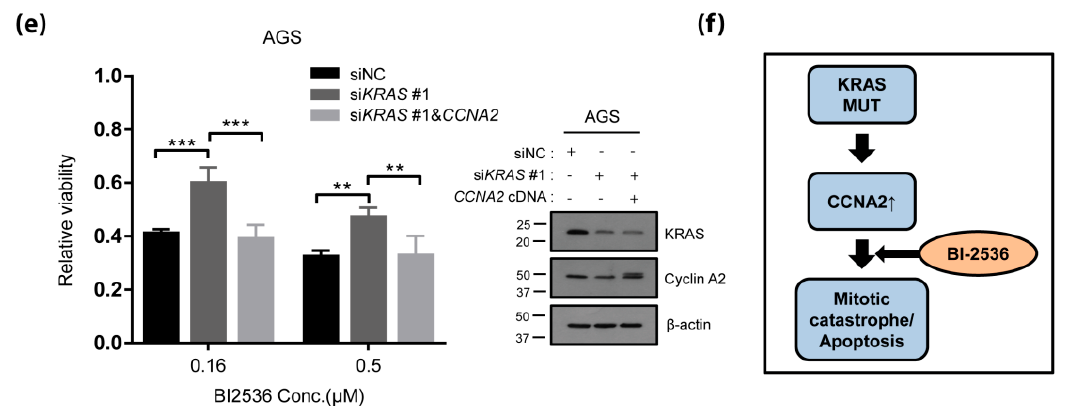
Figure 4. Oncogenic KRAS driven CCNA2 upregulation confers sensitivity of KRAS mutant cancer to PLK1 inhibitors.( a ) Comparison of CCNA2 expression levels between wild-type (WT) and pan- RAS ( KRAS , HRAS and NRAS ) or mutant KRAS tumor samples (pan-cancer and gastric cancer) in the Cancer Genome Atlas (TCGA) cohort; ( b ) cumulative distribution fraction plots of drug response (median-centered AUC) in the 37 gastric cancer cell lines show that KRAS mutant cell lines had higher sensitivity to BI-2536 and volasertib. p values were calculated by two-sided Kolmogorov–Smirnov tests (KS-test); ( c ) evaluation of cyclin A2 and KRAS expression by immunoblotting post knockdown of CCNA2 and KRAS in KRAS mutant gastric cancer cell lines (AGS, SK4 and SNU601). GAPDH was measured as an internal control; ( d ) relative viability of AGS cells expressing siKRASoligos at 72 h post treatment with BI-2536 (0.16 µ M) and volasertib (0.16 µ M). Expression changes of KRAS and cyclin A2 by expression of siKRASoligos were observed by immunoblotting. * p < 0.05, ** p < 0.01; Student’s t- test; ( e ) relative viability of AGS cells expressing siKRAS with or without CCNA2 cDNA at 72 h post BI-2536 (0.16 µ M and 0.5 µ M) treatment. Expression changes of KRAS and cyclin A2 were assessed by immunoblotting. ** p < 0.01, *** p < 0.001; two-way ANOVA; ( f ) Hypothetical model of selective toxicity to PLK1 inhibitor in KRAS mutant cancer.